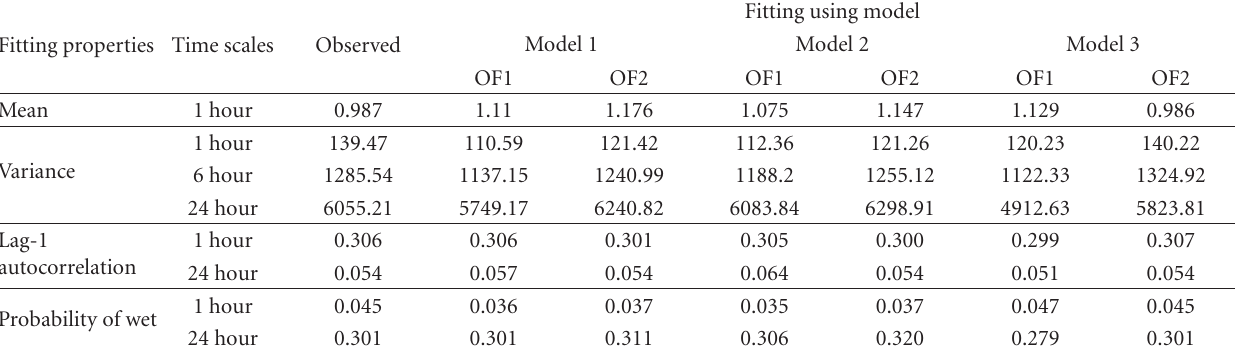
Table 3: Observed rainfall statistics for July with corresponding properties for the fitted